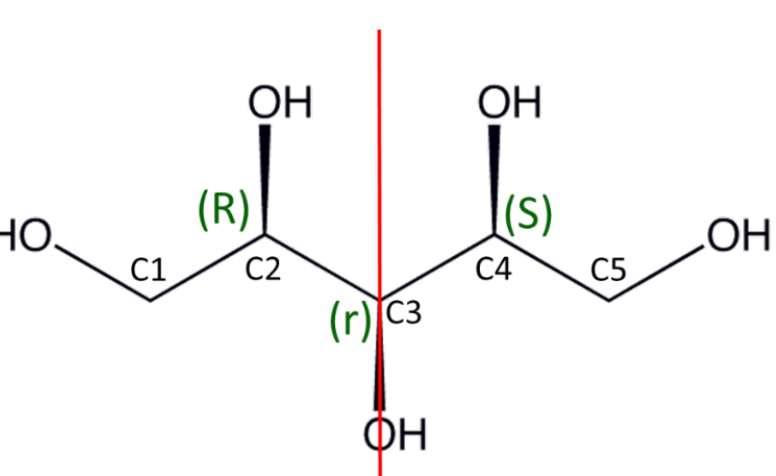
Figure 2. The structure of the xylitol molecule, atom numbering system and absolute configurations. The red line is the mirror plane.